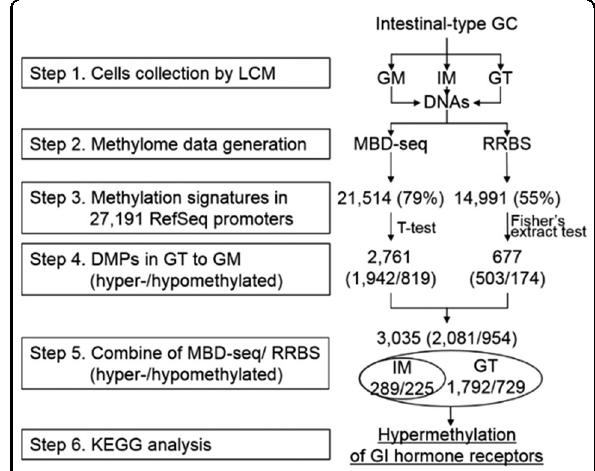
Fig. 1 Schematic diagram of DNA methylation pro fi ling of gastric carcinogenesis using MBD-seq and RRBS. The six-step process of the initial methylome pro fi ling, identi fi cation of the promoter DMRs, and pathway analysis associated with gastric